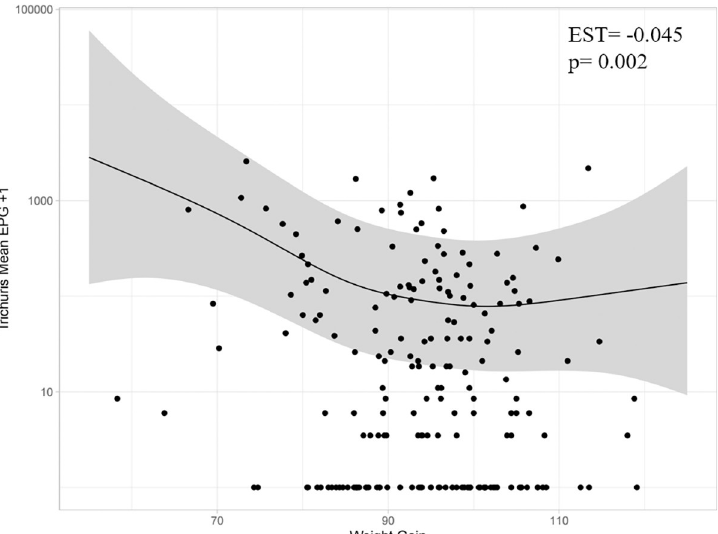
Fig 3. The relationship between Trichuris suis mean EPG (log scale) and weight gain (week 0–14) estimated using a generalised additive model (GAM) (n = 195). The estimate is shown by solid black line and 95% CI are shown in grey shading. Individual data points have been overlaid for reference (black dots), with a constant of 1 added before log transformation for the purposes of visualization only. Inset are the estimate (EST) and p-value generated using a generalised linear mixed model (GLMM) assuming that the relationship is linear.